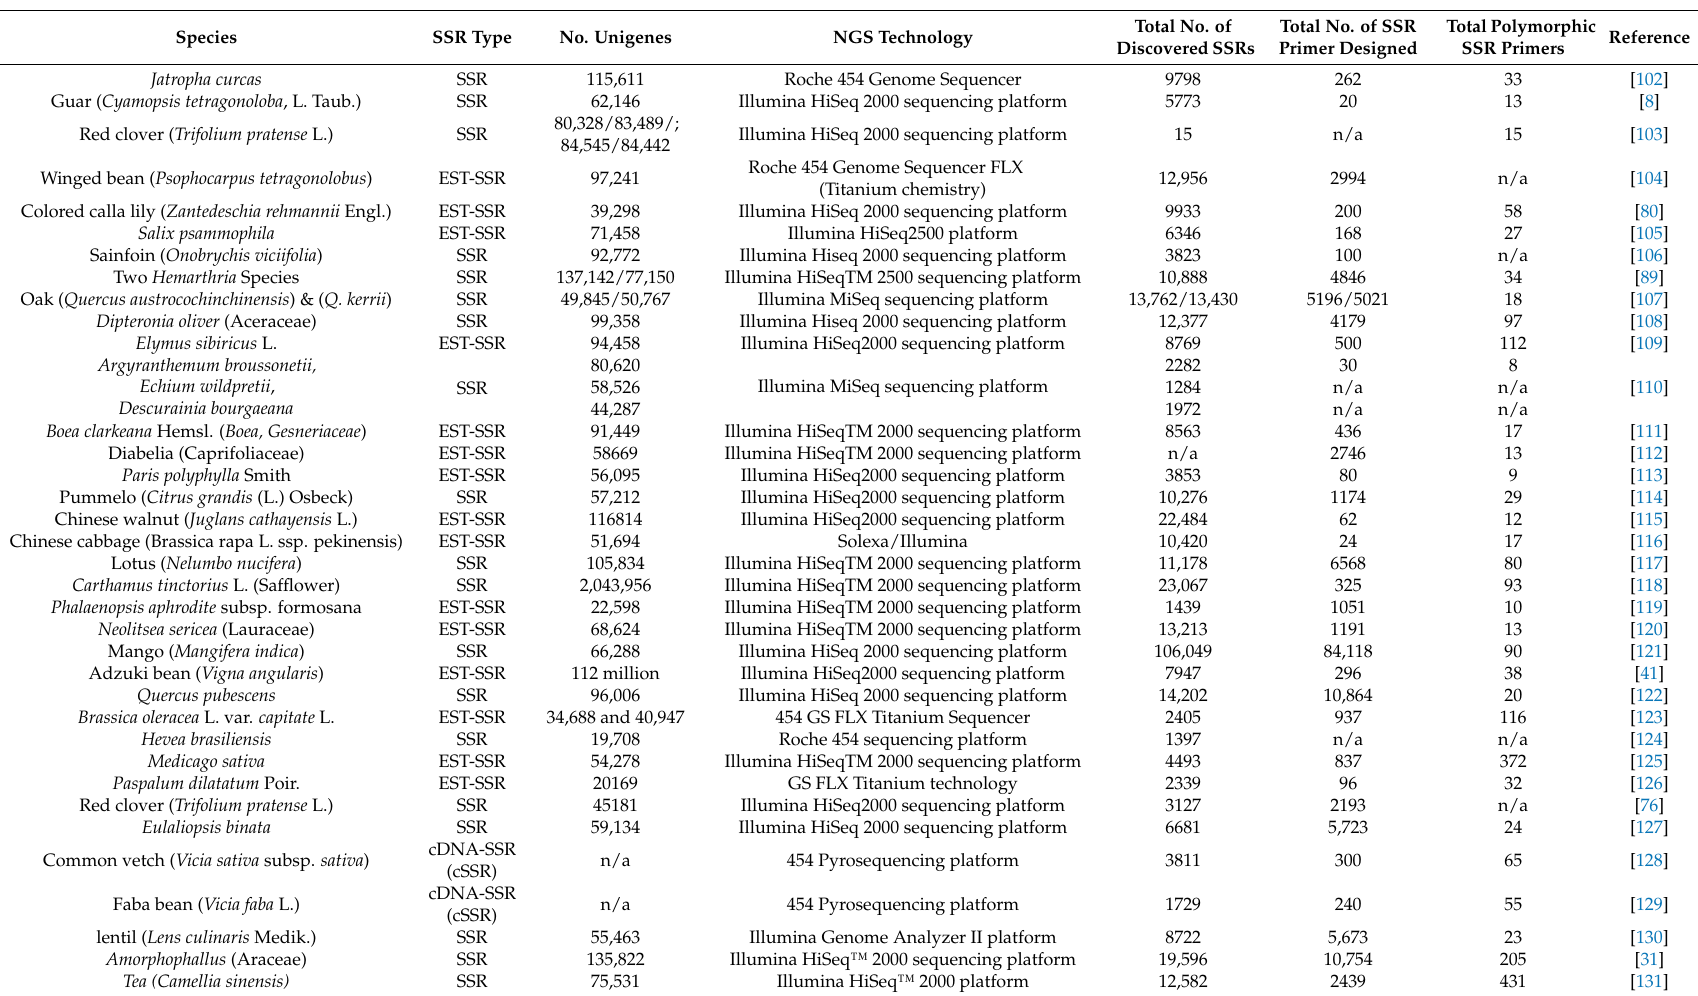
Table 1. Developed simple sequence repeat (SSR) markers using Illumina, and 454 sequencing technologies in